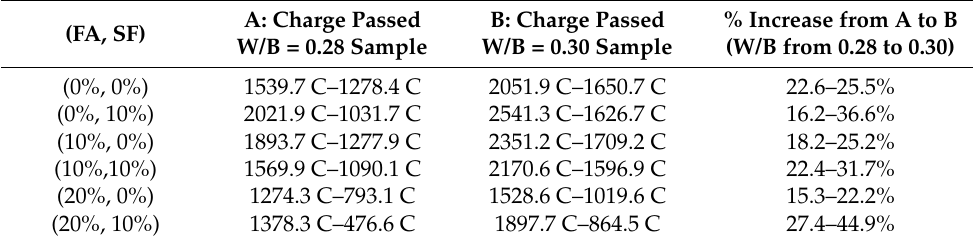
Figure 10. The electric charge passed through HPC samples with a water/binder (W/B) ratio of ( a ) 0.28 or ( b ) 0.30. Note: FA = fly ash; SF = silica fume. Table 5. The electric charge passed through concrete samples of different